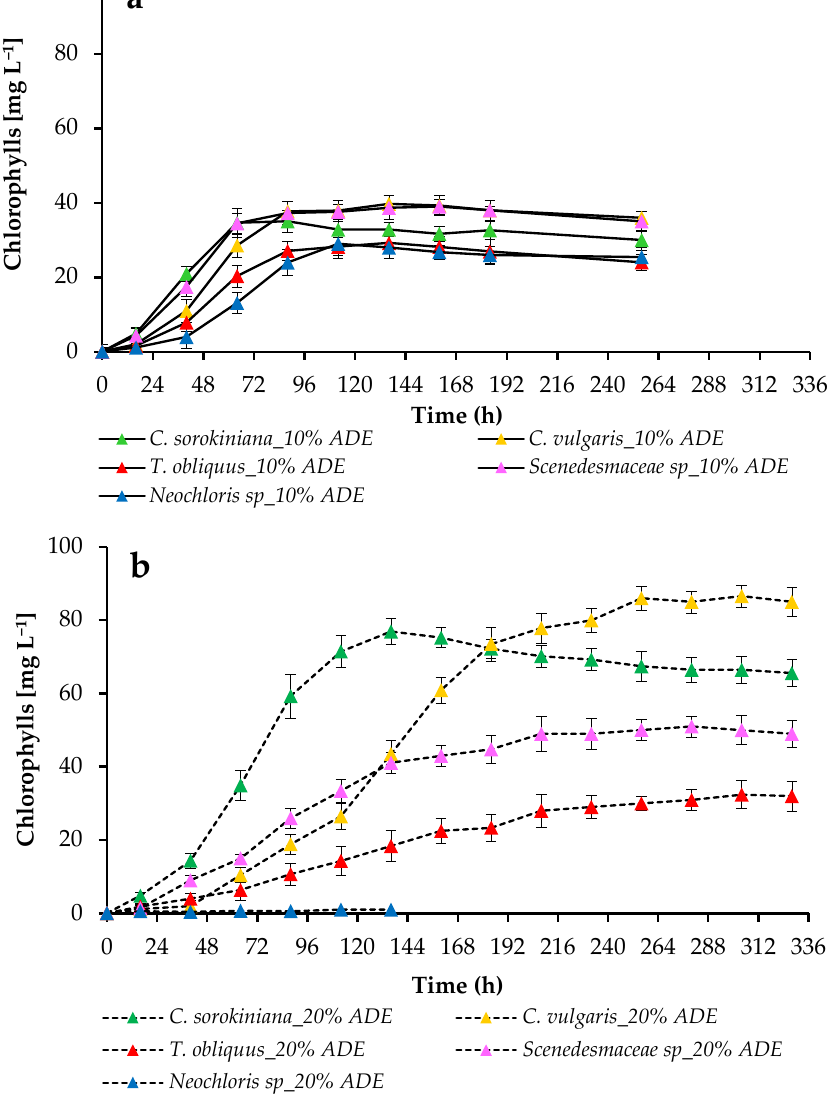
Figure 4. Chlorophylls concentration for cultures grown in 10% ADE ( a ) and 20% ADE ( b ). In experiments with 20% ADE, C. sorokiniana EZ ‐ 07 and C. vulgaris SB ‐ M4 demon ‐ strated the highest content of chlorophylls a and b , although C. sorokiniana EZ ‐ 07 accumu ‐ lated them faster. The lowest content of chlorophylls a and b was also observed in T. obliquus EZ ‐ K8 cultured in 20% ADE (Figure 4b). This may be due to both the features of